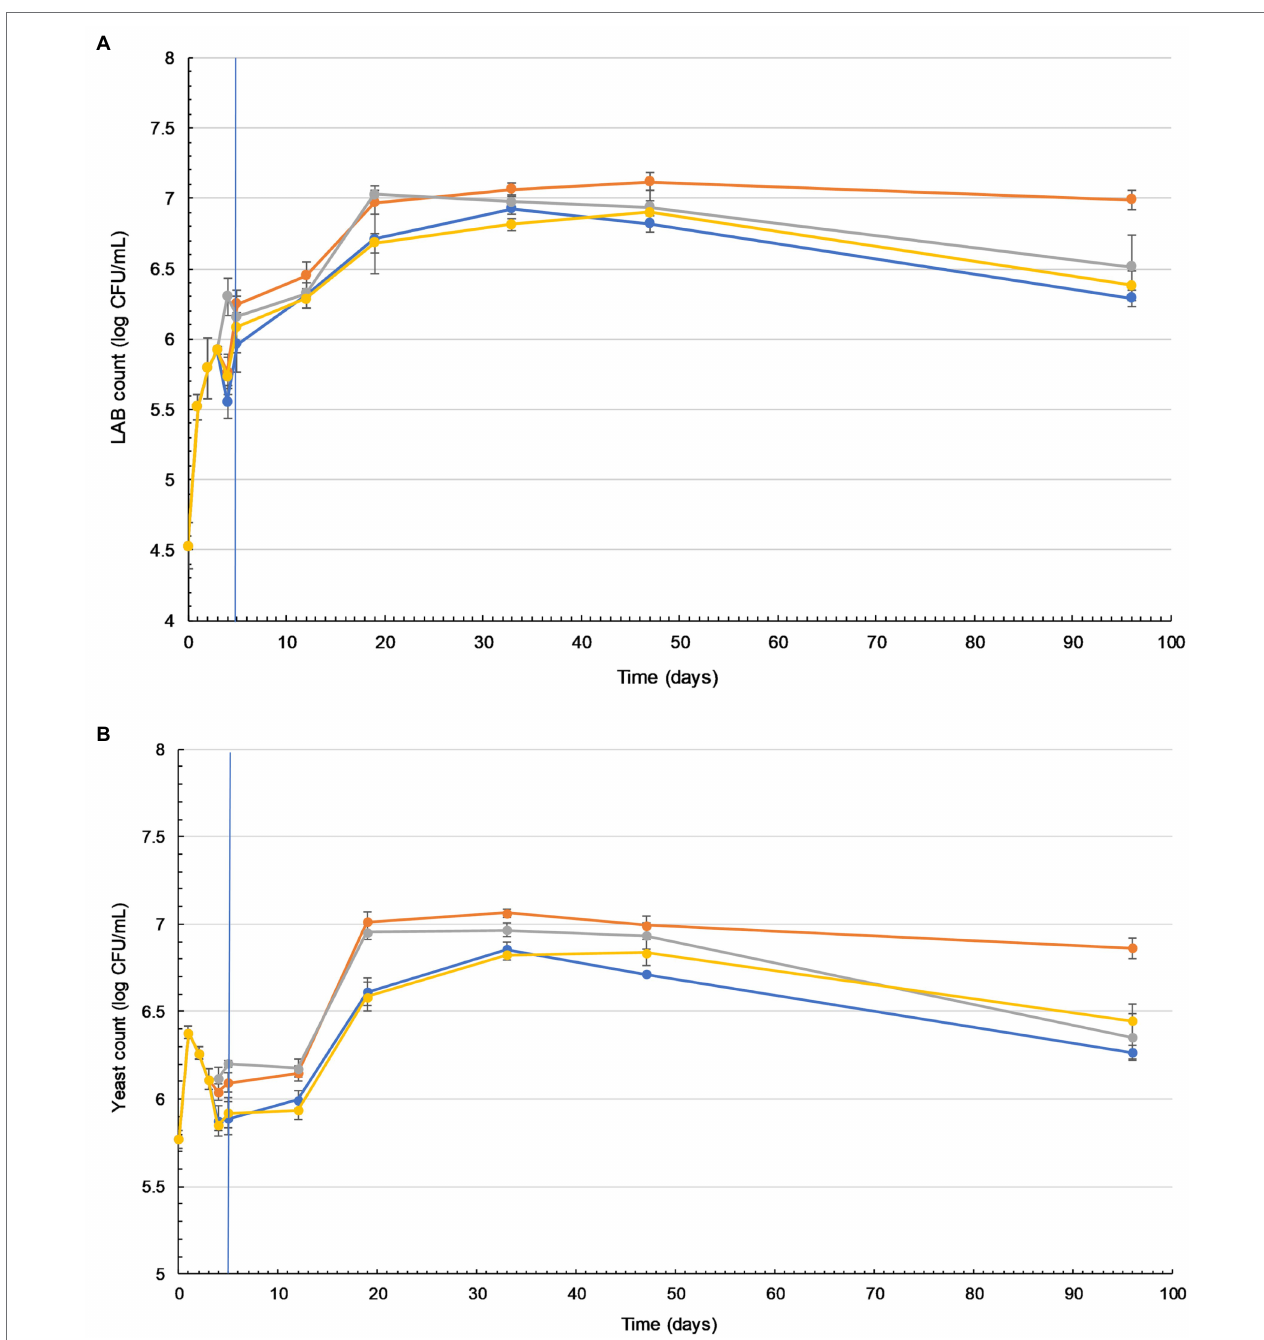
FIGURE 2 | Lactic acid bacteria (LAB) and yeast counts in tibicos increase during storage and are significantly higher when ginger is added. Changes in viable LAB (A) and yeast (B) counts in four tibicos treatments during fermentation (20–25 ° C for 3 days with tibicos; and with three different additives added on day 3 for 2 days of secondary fermentation without tibicos and storage at 4 ° C for a further 86 days). ( ) Plain tibicos; ( ) tibicos with 0.5% ( w / v ) organic ginger powder; ( ) tibicos with 0.125% ( w / v ) organic cayenne powder; ( ) tibicos with 0.25% ( w / v ) organic turmeric powder. Sampled daily during fermentation and on days 12, 19, 33, 47, and 96. The timeline of fermentation with the tibicos grains and separation to enter storage is indicated by the vertical blue line. The results were expressed as mean standard deviation ( n = 3) for each treatment